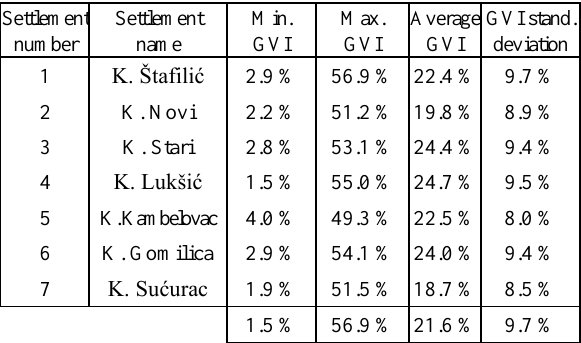
Table 3. Minimum, maximum, average, and standard deviation of the GVI values for each of the seven settlements